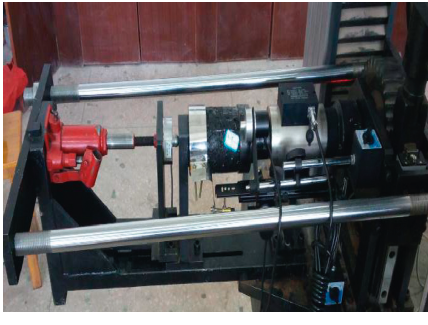
Figure 2: Torsion test